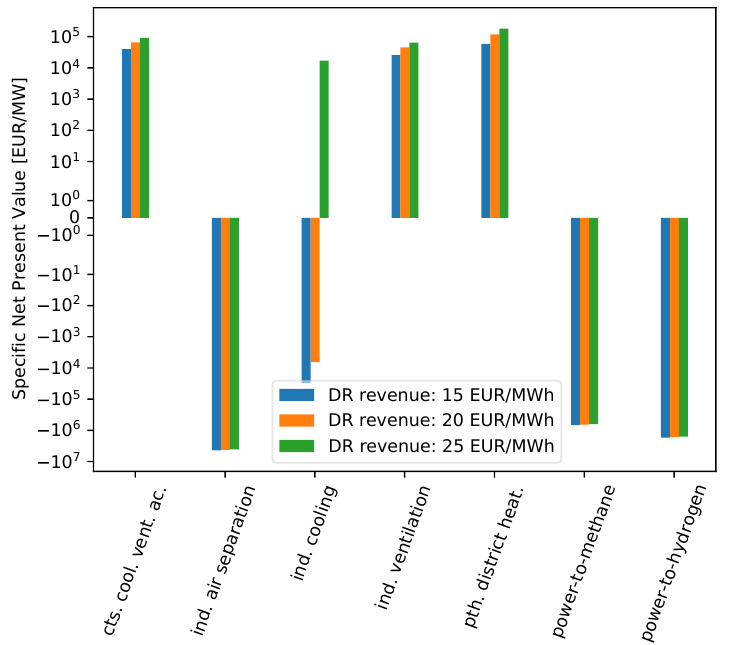
Figure 14. Specific net present values for the DR technologies at a grid node close to the city of Dortmund for the case with investment costs considered.